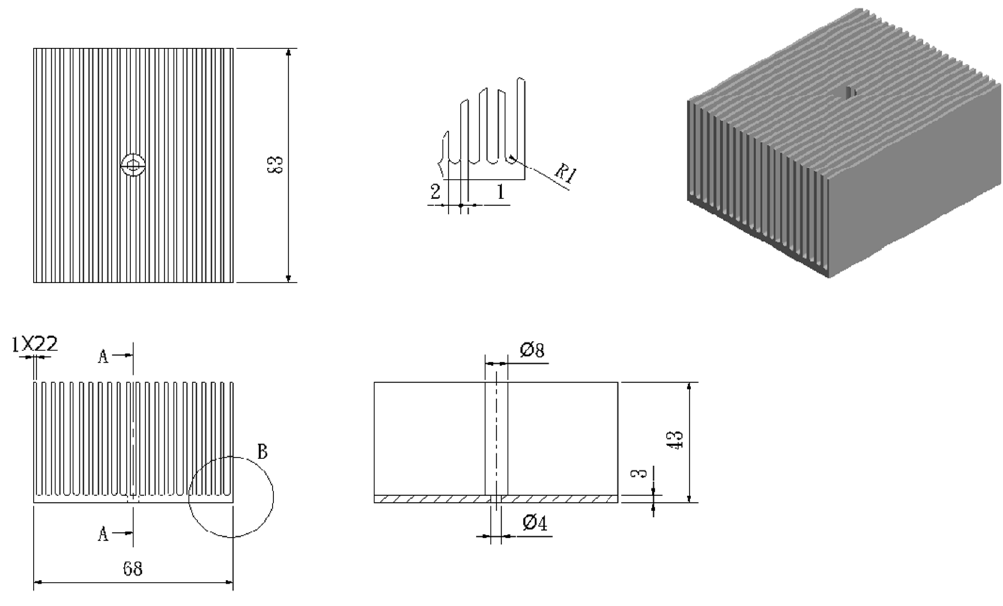
Figure 1. Thermal resistance measurement apparatus for CPU coolers.